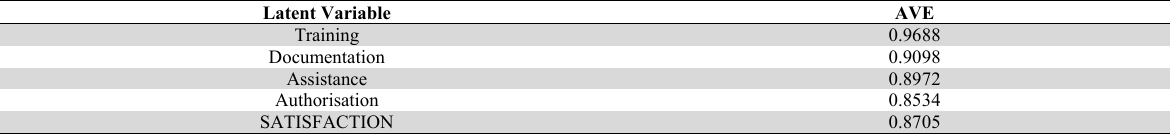
The average variance extracted for each reflective